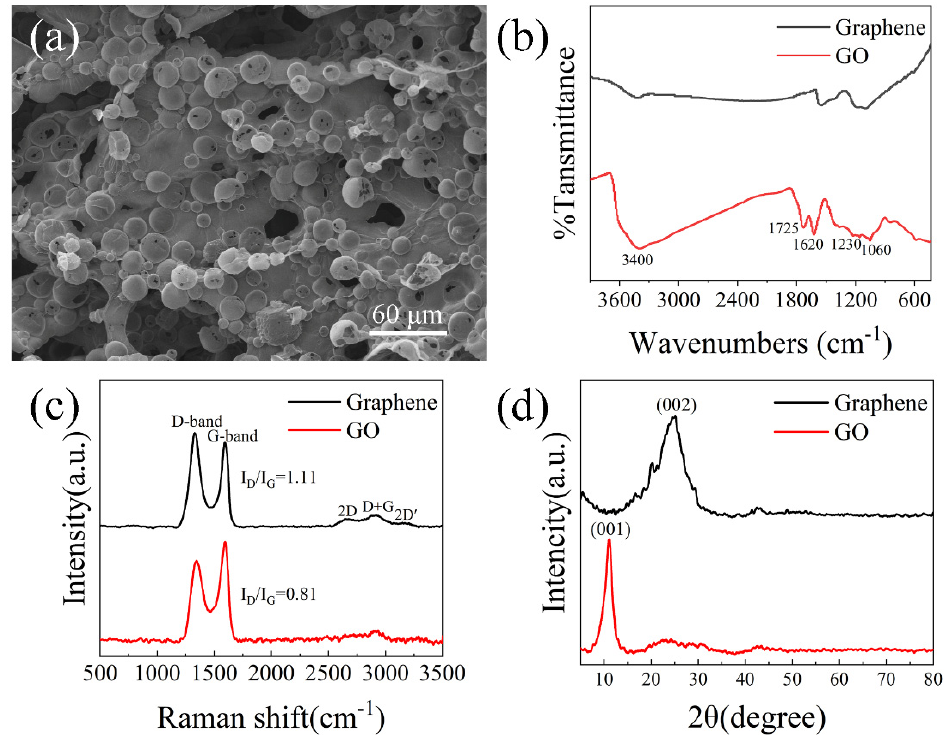
Figure 3. Characterization of OCGA. ( a ) SEM image of OCGA. ( b ) FTIR spectroscopy, ( c ) Raman spectra and ( d ) XRD patterns of GO before and after reduction.